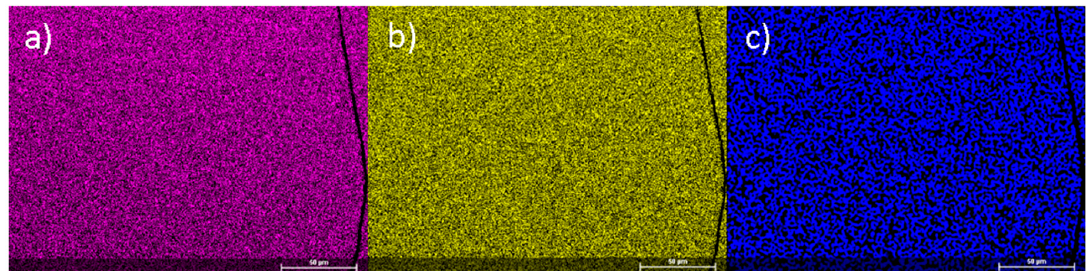
Figure 3. Element mappings of a polished ingot for ( a ) iron (pink), ( b ) manganese (yellow) and ( c ) nitrogen (blue). The metallographic specimen of the target phase Fe 2 MnN exhibits homogeneous color distributions and, thus, chemical composition.